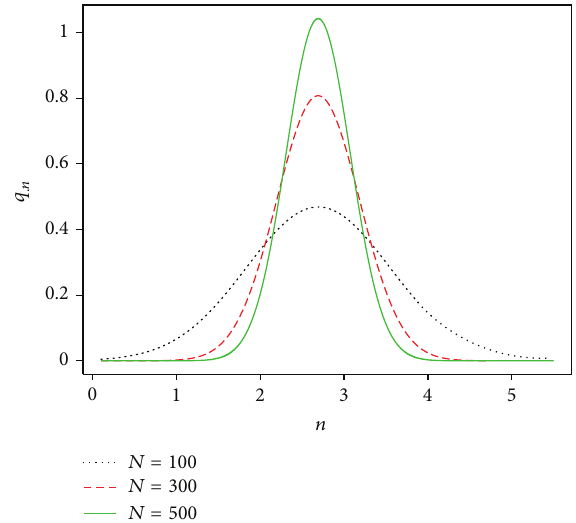
Figure 1: The quasi-stationary distribution for different values of 𝑁 and other parameters are as in Table 3.